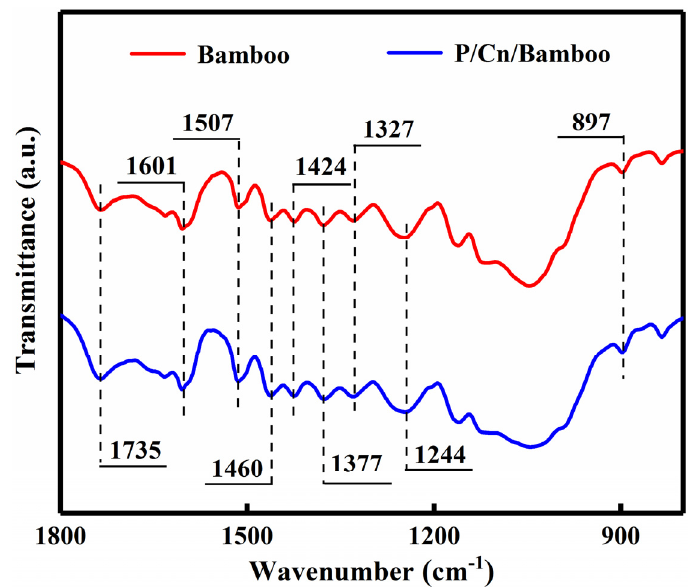
Figure 7. The FT − IR spectra of impregnated bamboo strips.